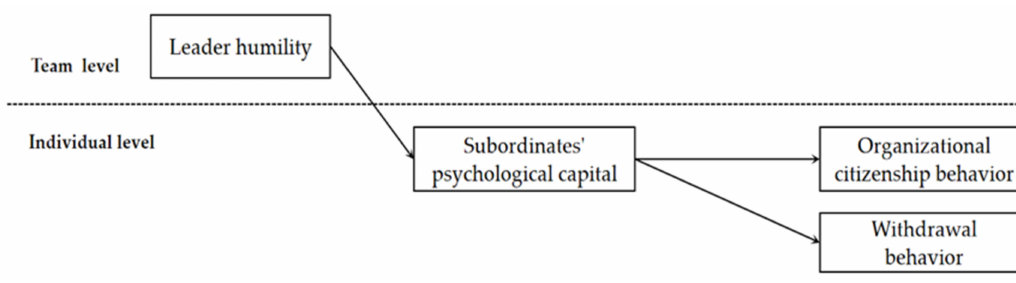
Figure 1. Theoretical